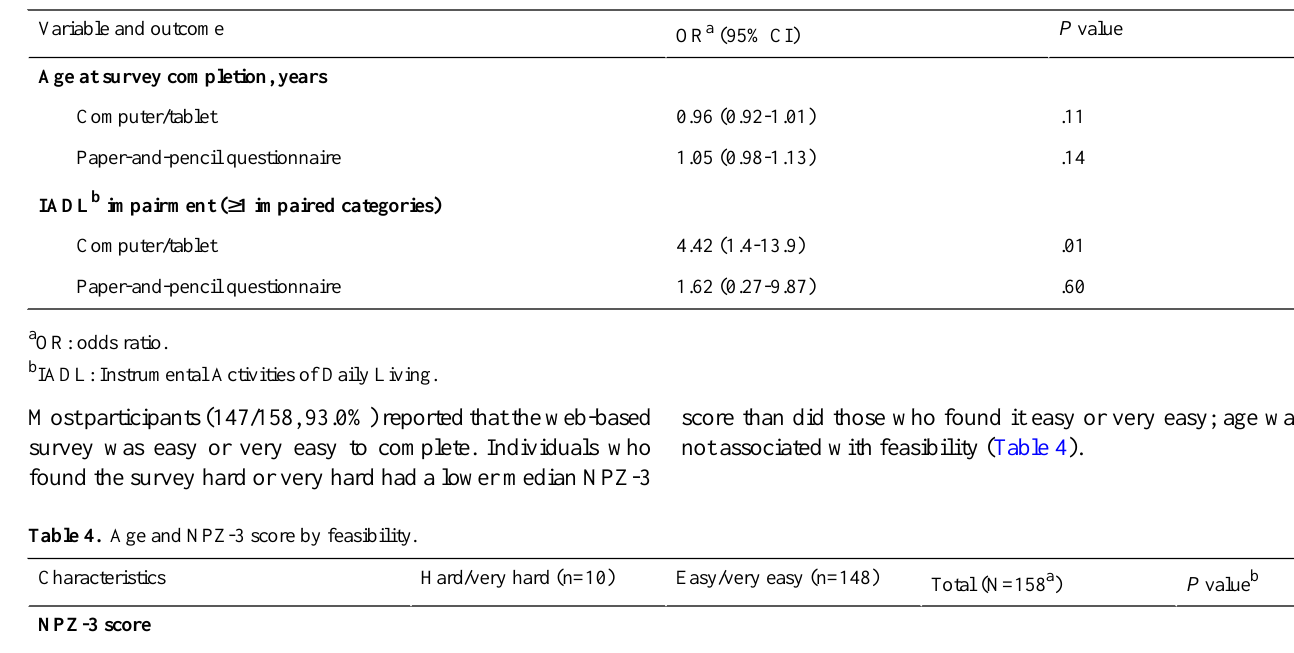
Table 3. Multinomial logistic regression model: factors associated with acceptability (no preference as the reference group).